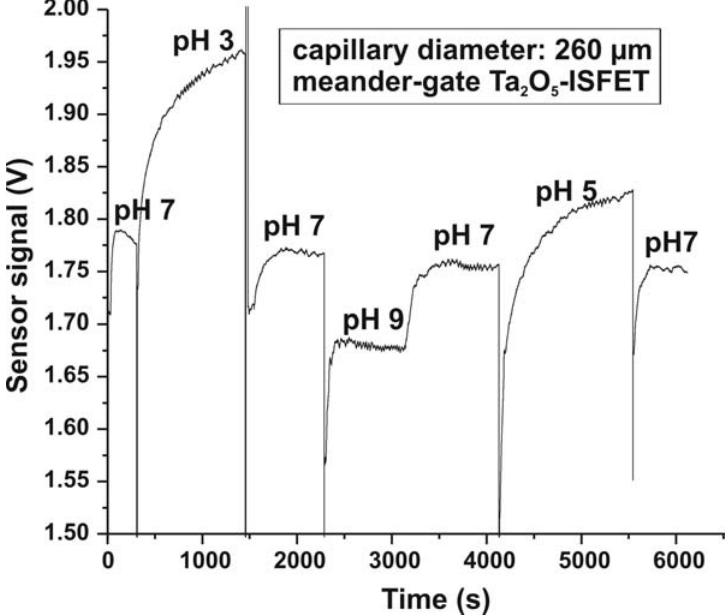
Figure 7. Constant-charge-mode dynamic response of a meander-shaped Ta Figure 5) in buffer solutions of different pH values from pH 3 to pH 9 measured at wafer level by means of the developed experimental set-up with the micro-droplet